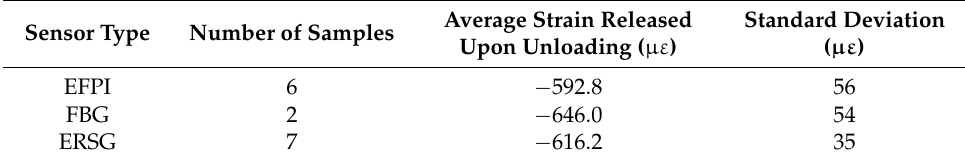
Table 6. The average strain released when the composites were un-loaded from the pre-stressing ring. The preforms were previously subjected to a pre-stress of 108 MPa.